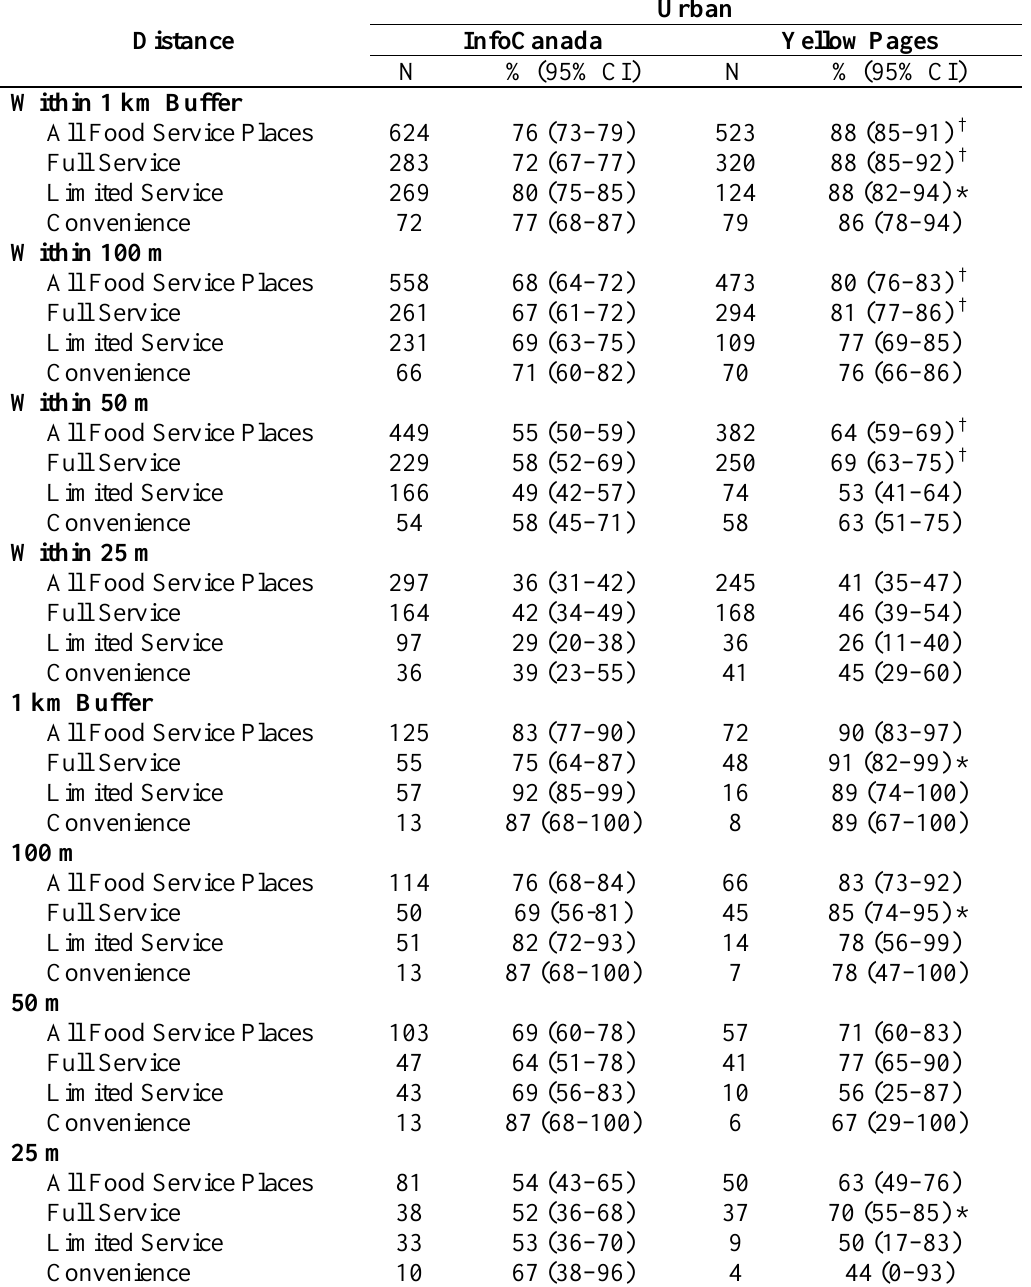
Table 1. The proportion of food service places in the GIS databases that were found in the field